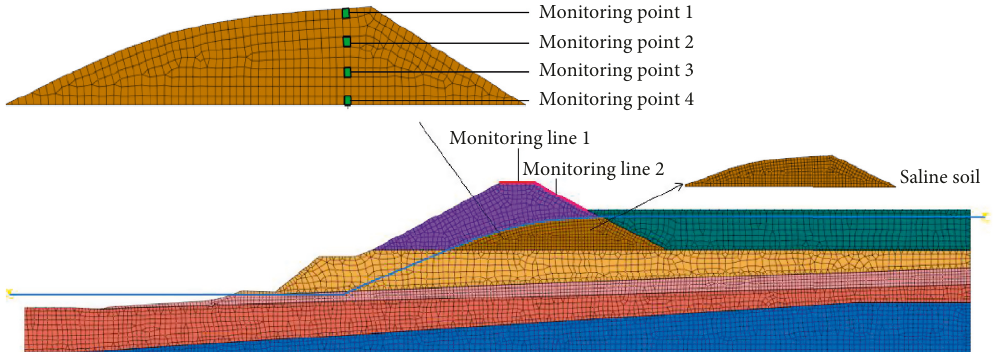
Figure 14: Monitoring lines and monitoring points of the